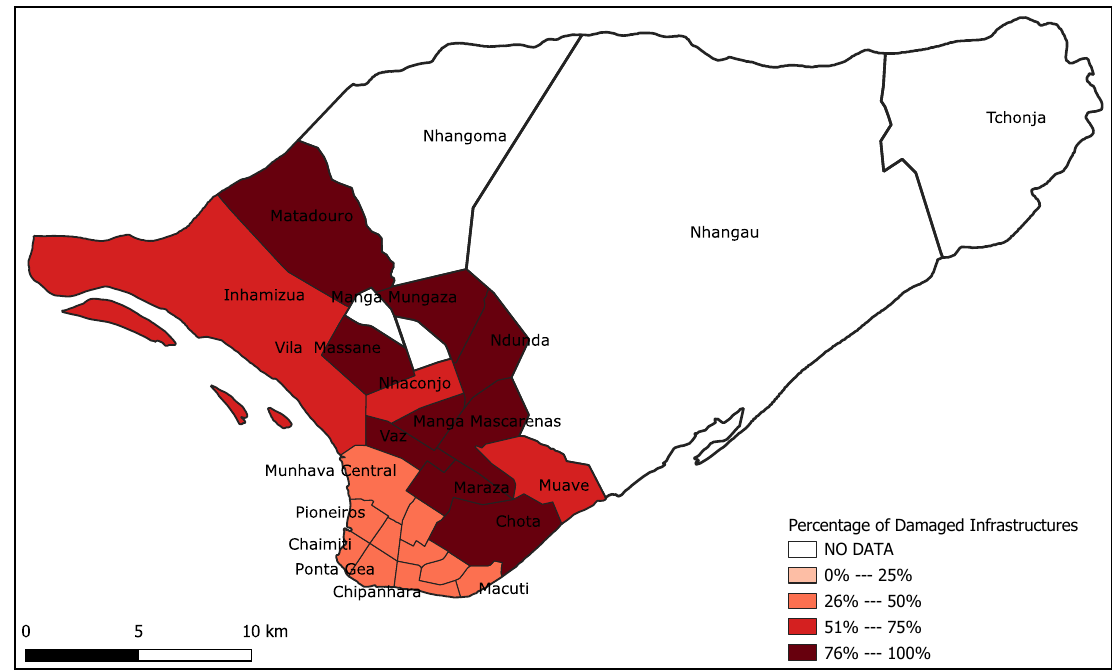
Figure 13. Percentage of damaged infrastructure per